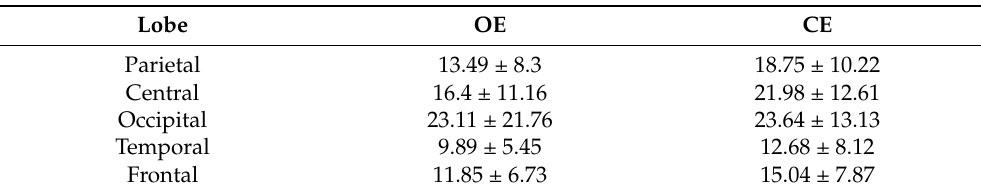
Table 3. Average results, by cerebral lobes, of the alpha band absolute power (µV2/Hz) obtained in the control tests opened eyes (OE) and closed eyes (CE).